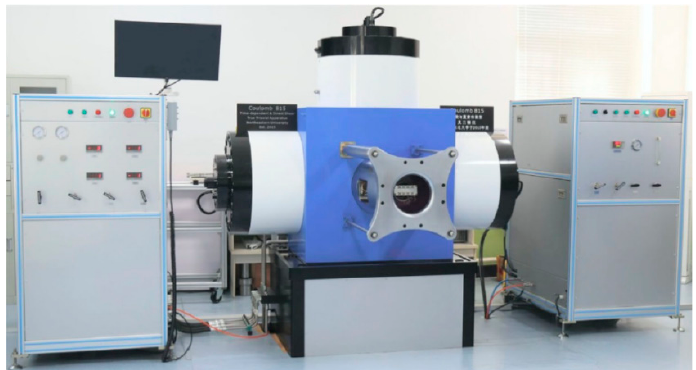
Figure 1. Self-developed true triaxial test apparatus [23].